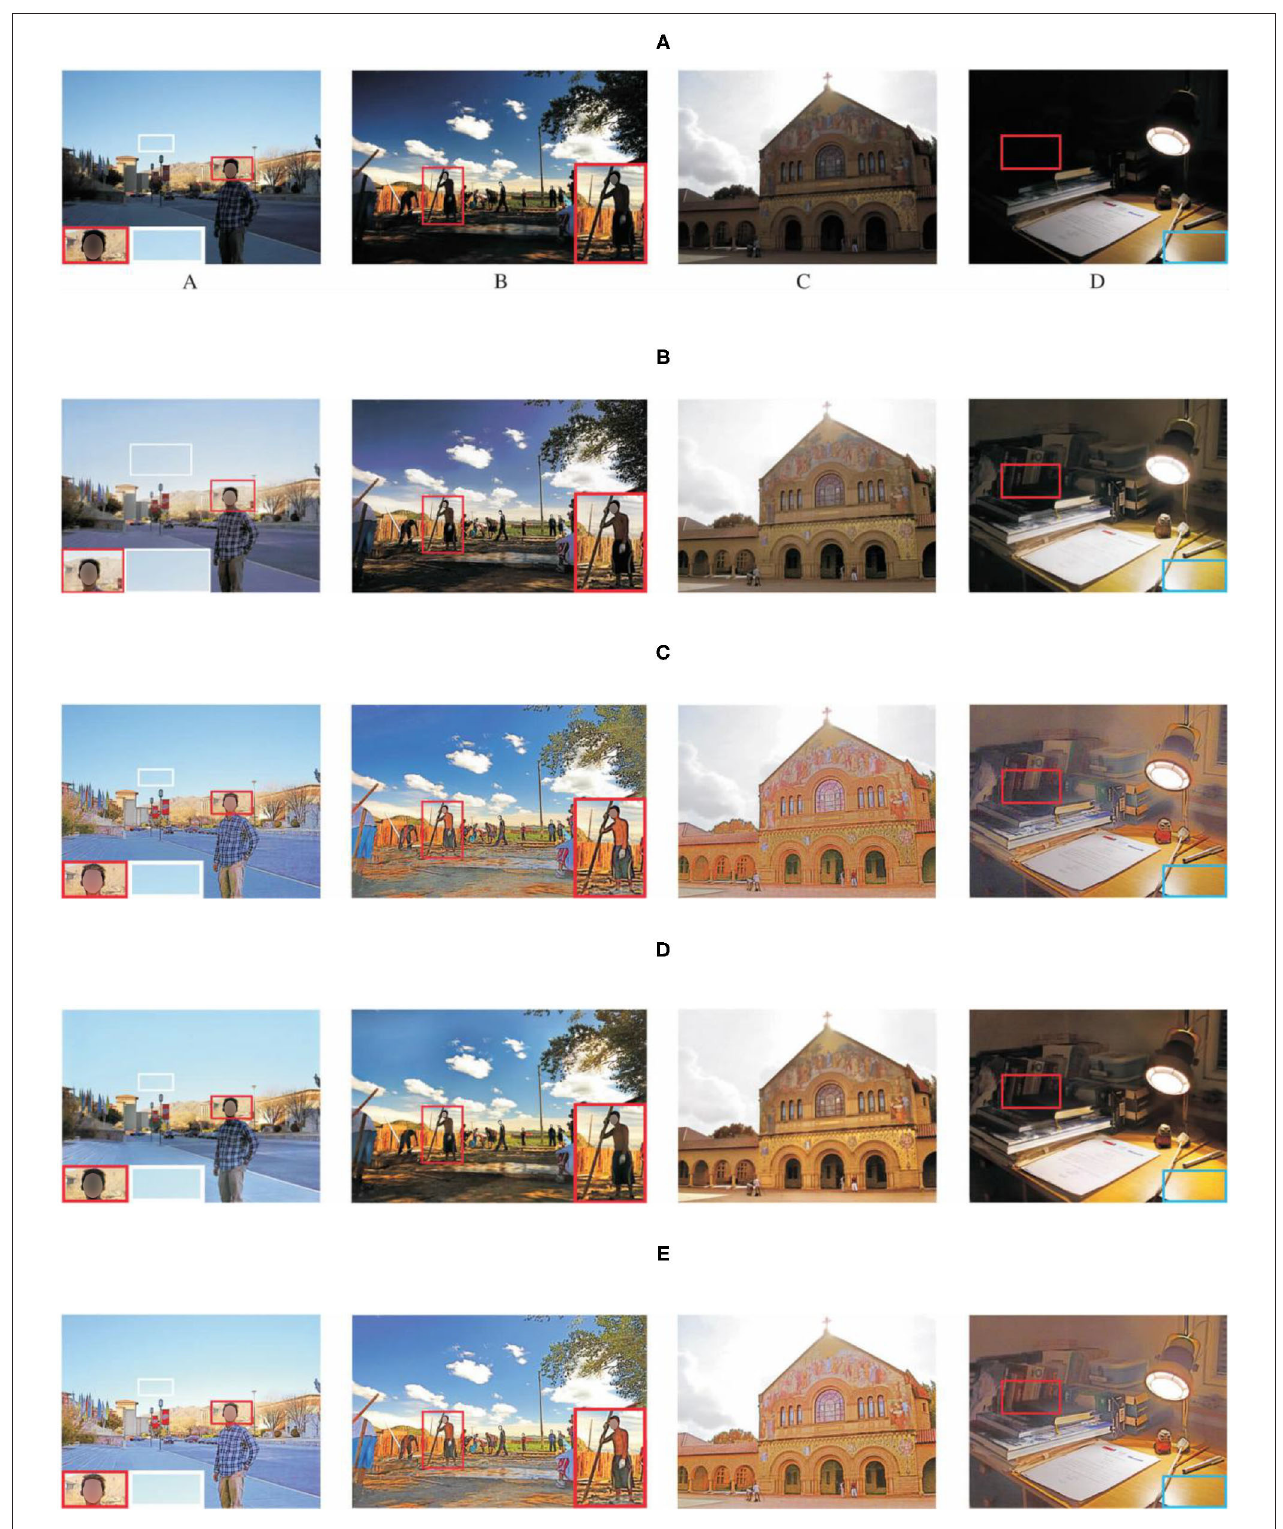
FIGURE 6 | Comparison results with different algorithms on DICM and MEF datasets. (A) Input images, (B) SEM method, (C) VBSA method, (D) APM method, and (E) proposed method.